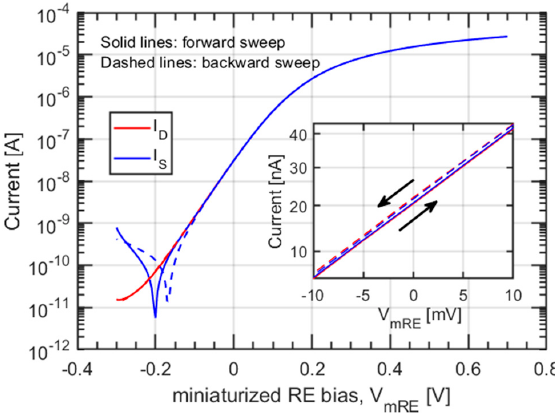
Figure 3. Double-sweep transfer characteristics, I D -V mRE , of the ISFET under characterization for an electrolyte with pH = 7. The inset on the right shows the ultralow (<1 mV) measured hysteresis. Data from a continuous sampling of the drain current, while changing pH buffer has been used to calibrate the model of the site-binding kinetics at the sensing layer, i.e., the